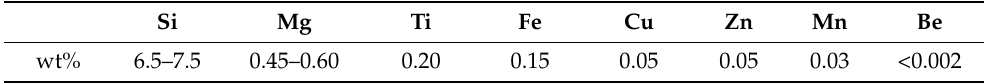
Table 1. Nominal composition of the F357